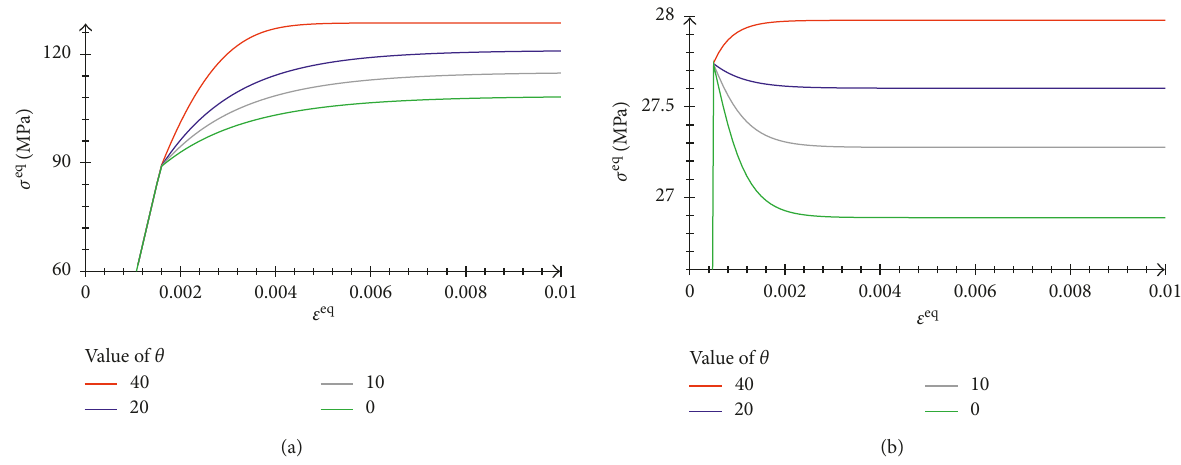
Figure 7: Equivalent stress-strain curves for various dilatancy angles: (a) compression; (b)